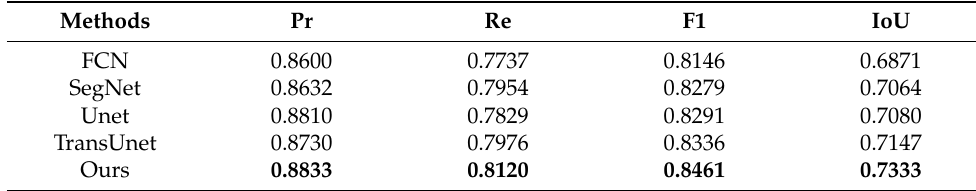
Table 4. The Pr, Re, F1, and IoU of compared methods for the DeepCrack